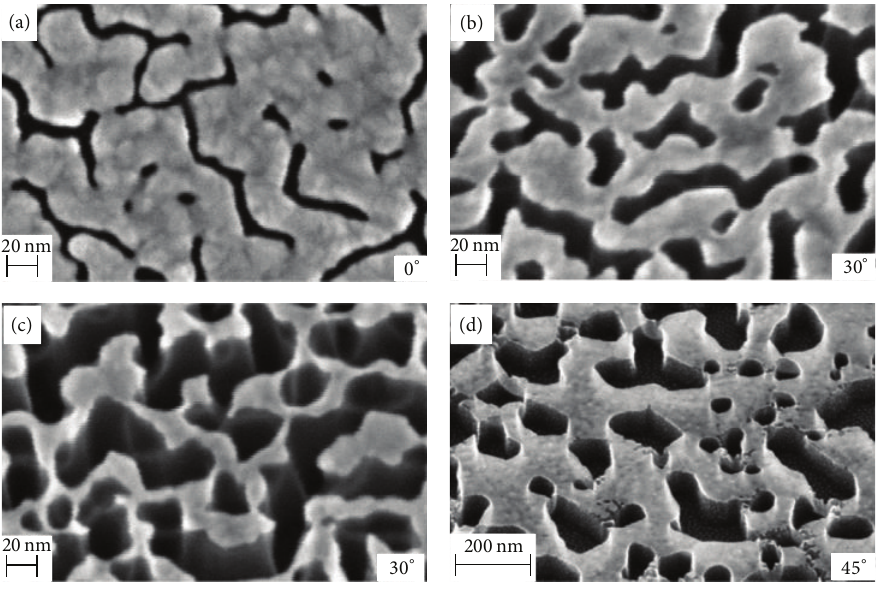
Figure 5: SEM images of nanstructures produced by RIE: (a) Au mask, (b) and (c) the samples after etching the substrate during 20 and 25 min, respecticely, and (d) a sample of Figure 4(d) with extra nanoholes appeared in the mask. The view angles are shown.